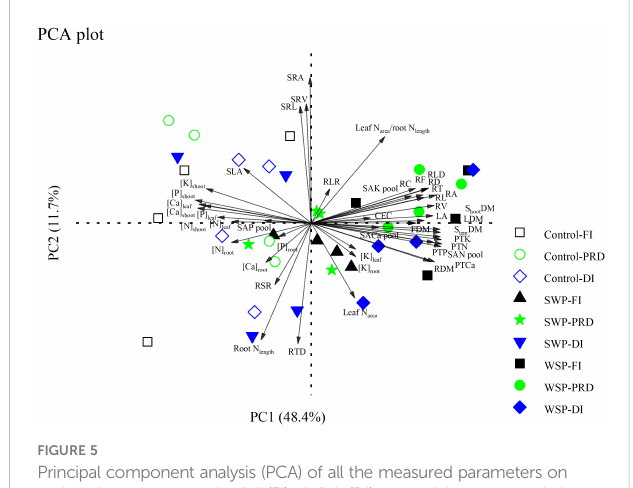
FIGURE 5 Principal component analysis (PCA) of all the measured parameters on maize plants grown under full (FI), de fi cit (DI), or partial root-zone drying (PRD) irrigation without (Control) and with softwood (SWP) and wheat- straw (WSP) biochar applied at 2%. The parameters are as follows: aboveground traits (LA, SLA, LDM, S tem DM, FDM, S hoot DM, [N] leaf , [N] stem , [P] leaf , [P] stem , [K] leaf , [K] stem , [Ca] leaf , [Ca] stem , and leaf N area ), belowground traits (RDM, [N] root , [P] root , [K] root , [Ca] root , RL, RA, RD, RV, RT, RF, RC, SRL, RLD, RTD, SRA, SRV, and root N length ), and resource possession (CEC, SAN pool, SAP pool, SAK pool, SACa pool, PTN, PTP, PTK, PTCa, RSR, RLR, and leaf N area /root N length ). The black, blue, and green graphs represent FI, DI, and PRD, respectively. The hollow and solid graphs represent non-biochar controls and biochar additions,